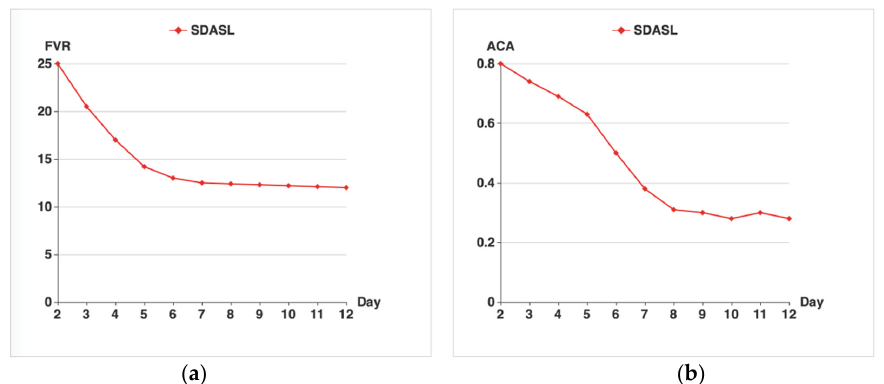
Figure 7. Relationship between FVR, ACA, and time in the SDASL model; ( a ) Description of the change of the FVR; ( b ) Description of the change of ACA.